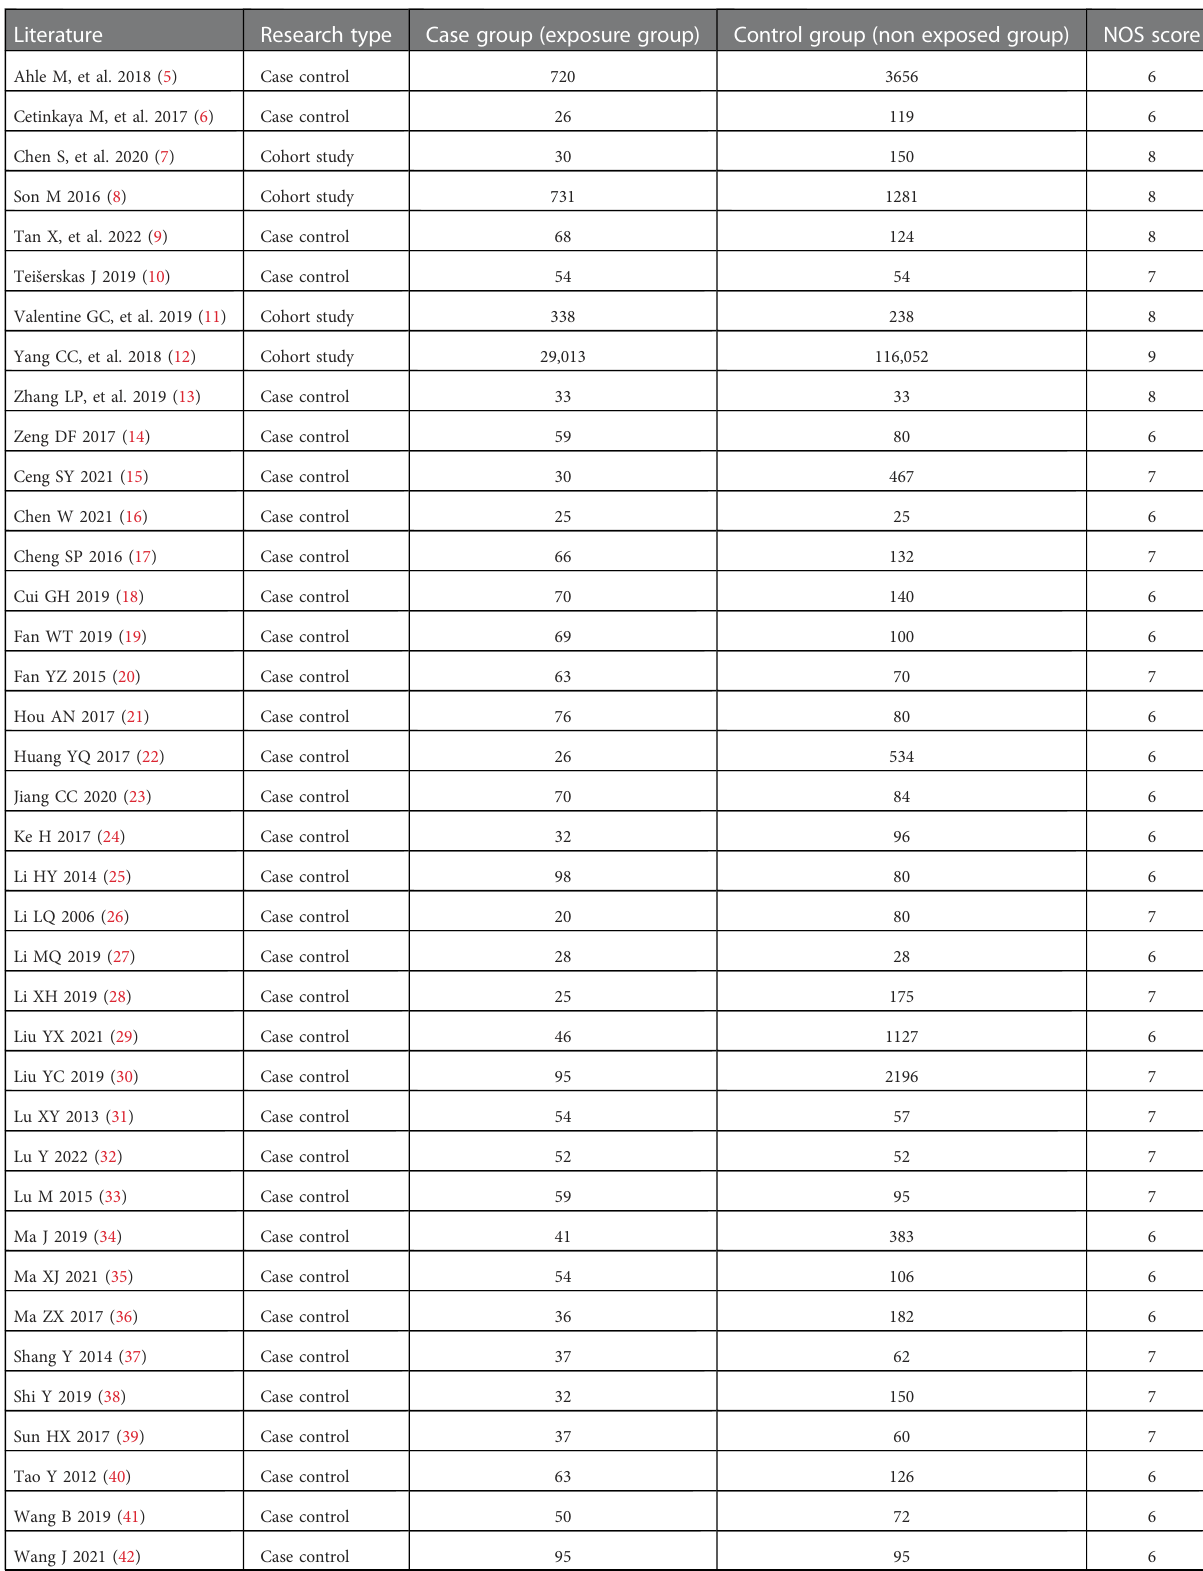
TABLE 1 Characteristics of included